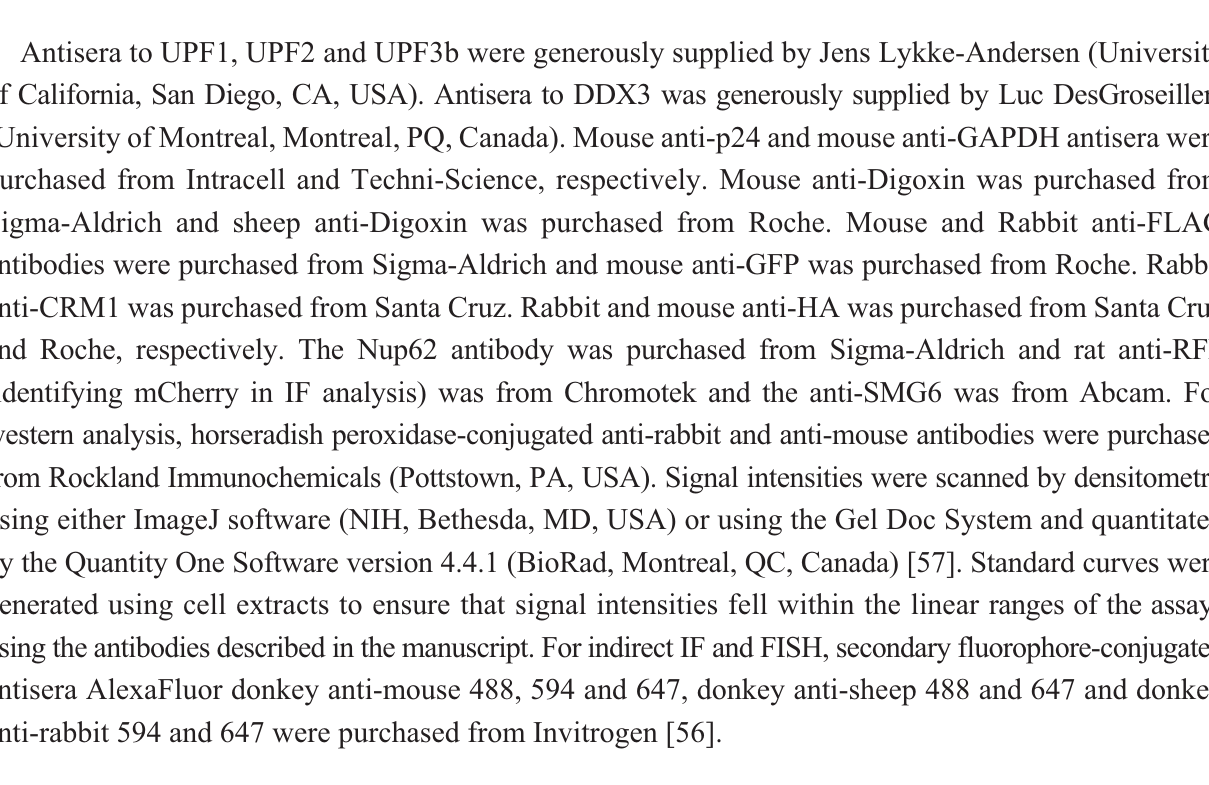
Figure 1. UPF1 nucleocytoplasmic shuttling promotes vRNA nucleocytoplasmic export ( A ); The UPF1 nuclear export and localization sequence (NES, NLS) domains are shaded in the depiction of UPF1. HeLa cells were co-transfected with wildtype proviral DNA (PNL4-3) alone ( B ); or a Rev-defective provirus pMRev((cid:2)) alone ( C ); or with UPF1 WT ( D ); UPF1 (cid:3)NES ( E ); and UPF1 (cid:3)NLS ( F ). vRNA shown in red and UPF1 proteins are shown in green (in all panels). White arrowheads identify HIV-1-transfected cells. Size bars indicate 10 μm. The corresponding Intensity plots for vRNA (red) and GFP-tagged UPF1 protein staining are shown from point A to B in the designate cells: dashed lines demarcate the nucleus (N) and cytoplasm (C) boundaries. Imaging results shown are representative of the phenotypes observed in >85% cells in each condition in 5 independent experiments. ( G ) Dunnett post-test analyses on vRNA localization results ±SEM values compared to the controls pNL4-3+GFP (pNL4-3) or GFP (Rev(cid:2)); *** p <